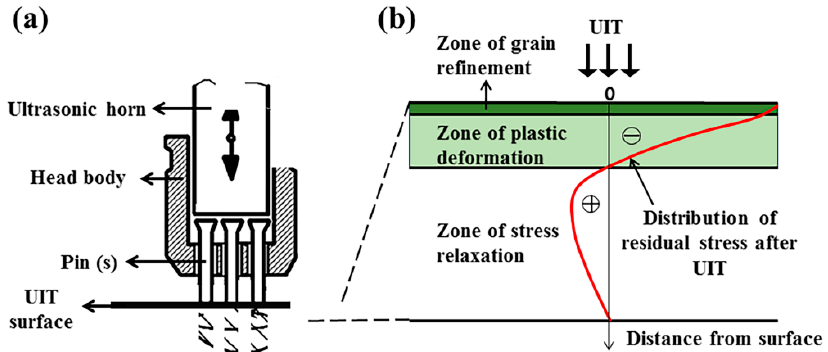
Figure 1. Schematic representation of the theory of ultrasonic impact treatment: ( a ) the impact head of the ultrasonic impact treatment (UIT) system, ( b ) the UIT influence area along the deposition direction [14].